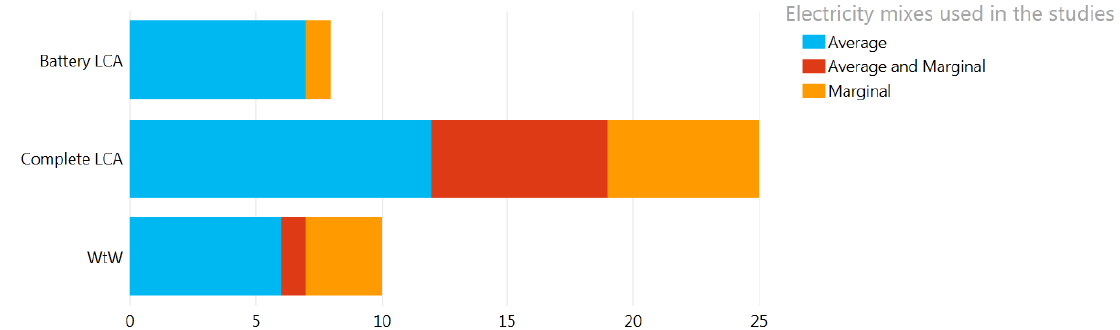
Figure 2. Number of LCAs sorted per study type and electricity mix selected.